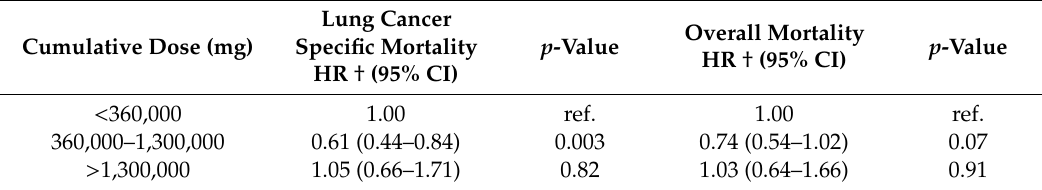
Table 4. HR and 95% CI of the association of metformin use, and lung cancer-specific and overall mortality by cumulative metformin